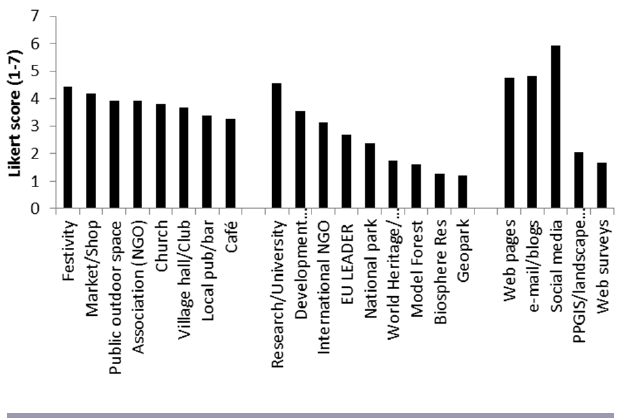
Fig. 5 . Histogram showing the mean Likert rank among 16 hotspot landscapes for traditional fora (left), novel fora (center), and virtual fora (right). PPGIS = Public Participation Geographic Information